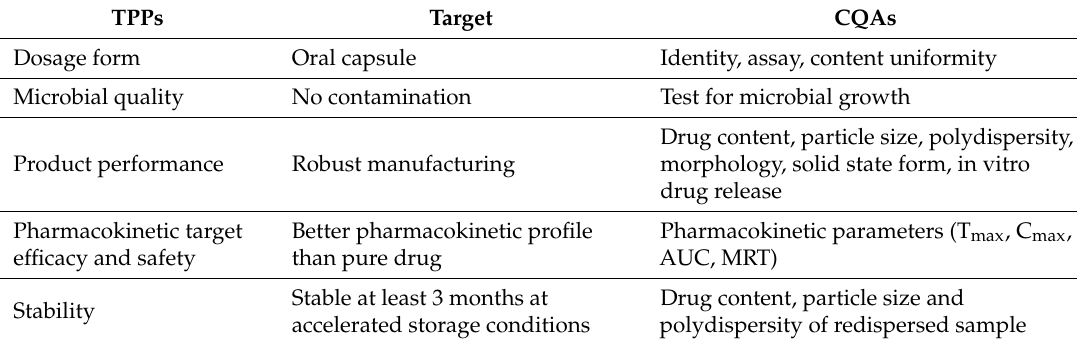
Table 3. Example of target product profiles (TPPs) for drug nanocrystals: case aceclofenac. Modified from